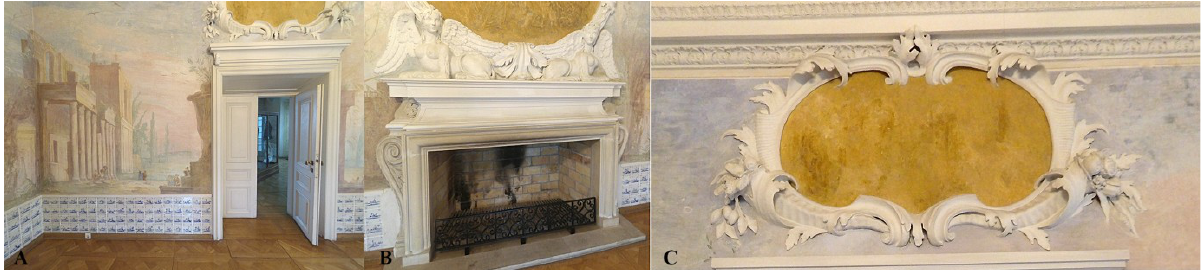
Figure 1. The example of decoration used in the process of low-cost Xiaomi 4K camera validation. A) N Wall with frescoes, B) Decorated fireplace with two antithetic figures of winged female sphinxes on the W wall, C) Fresco tondo in a decorative stucco frame above the N door.